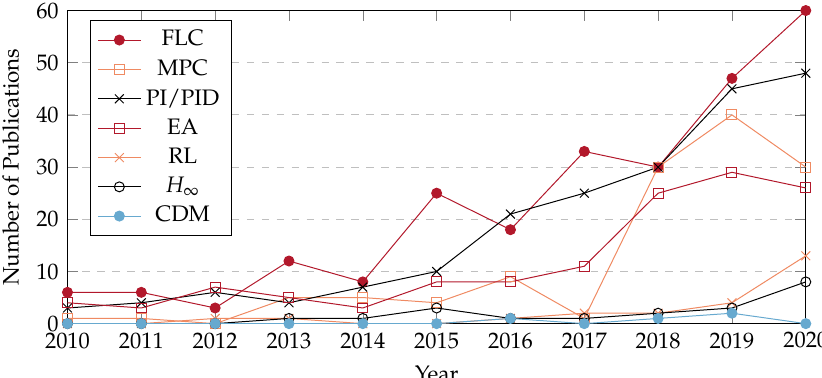
Figure 6. Trends in the frequency-support algorithms in microgrids. FLC—fuzzy logic controller, MPC—model predictive control, EA—evolution algorithm, RL—reinforcement learning, H ∞ —H- infinity, CDM—coefficient diagram